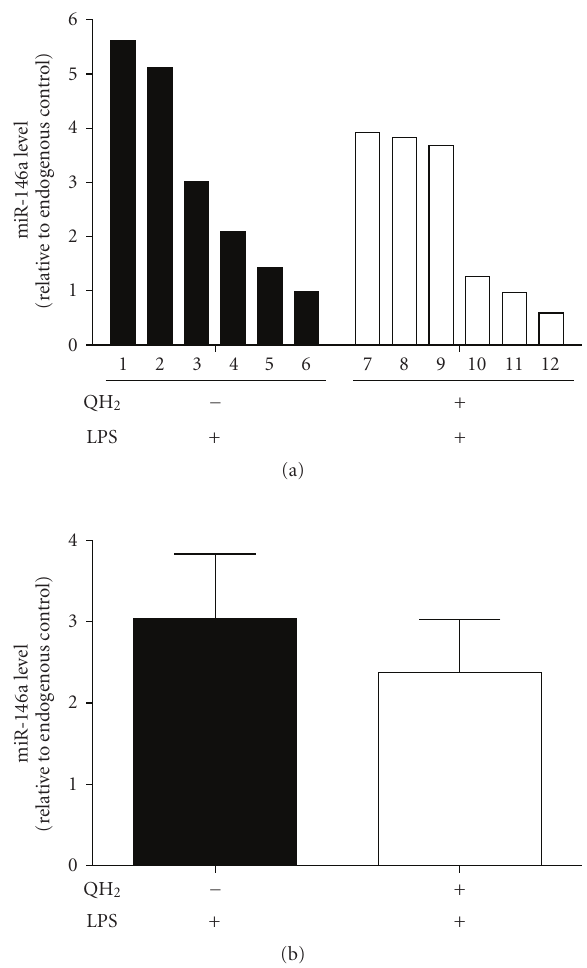
Figure 4: E ff ect of ubiquinol-10 supplementation on miR-146a expression in liver samples of LPS-treated mice. Mice were fed with ubiquinol-10 (250mg/kg/d) or a respective control diet (no ubiquinol-10 supplement) for 7 days. Afterwards, a sublethal intraperitoneal injection of LPS (1mg/kg BW) was administered for further 4 hours Thereafter, liver samples were collected, homoge- nized, and total RNAs including miRs were isolated as described by the manufacturer’s instructions. Subsequently, miRs were converted to cDNA and assayed by the TaqMan-based qRT-PCR. Observed miR-146a expression levels of each animal were related to the corresponding levels of the endogenous control (snoRNA202). Data (two-sided t -test) are means ± SEM of 6 animals in the intervention group (+QH 2 /+LPS) and control group (+LPS), respectively. miR- 146a expression levels are depicted as single bars of each animal (Figure 4(a)) or as total mean ± SEM of each group (Figure